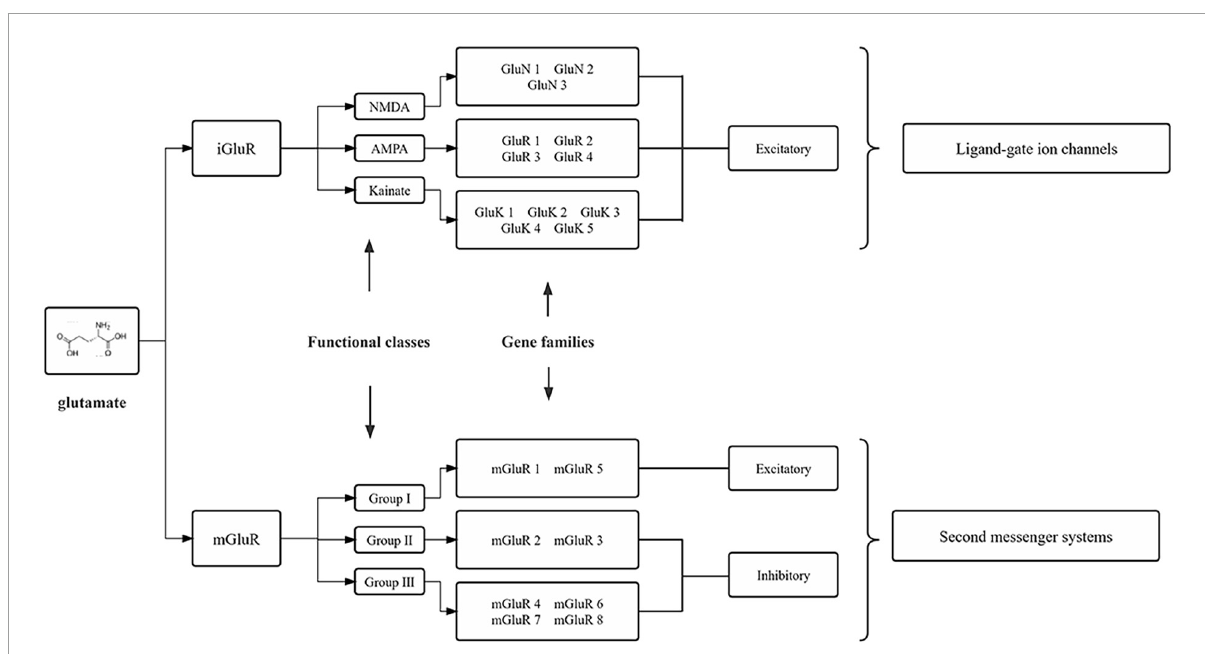
FIGURE1 Molecular families of glutamate receptors. The two main glutamate receptors are each composed of three functional definition groups of the receptor. Numerous individual subunits, encoded by different genes, make up these receptors. iGluRs, ionotropic glutamate receptors; mGluRs, metabotropic glutamate receptors; NMDA, N-methyl-D-aspartic acid; AMPA, α -amino-3-hydroxy-5-methyl-4-isoxazole-propionic